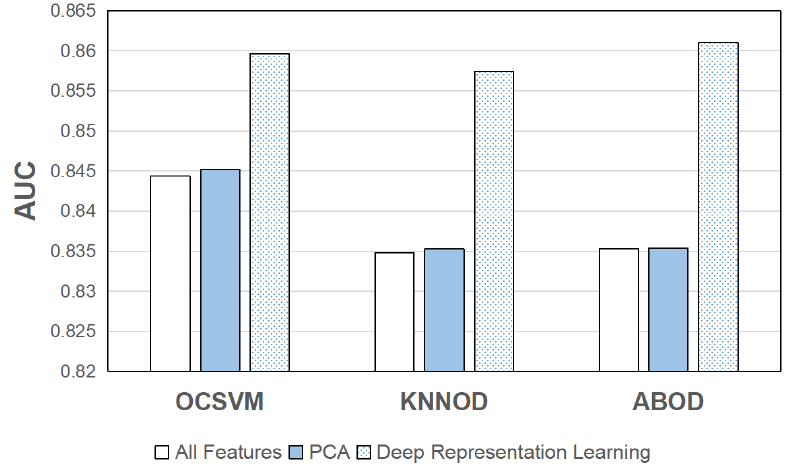
Figure 16. Performance of semi-supervised algorithms with and without feature extraction in terms of average AUC.